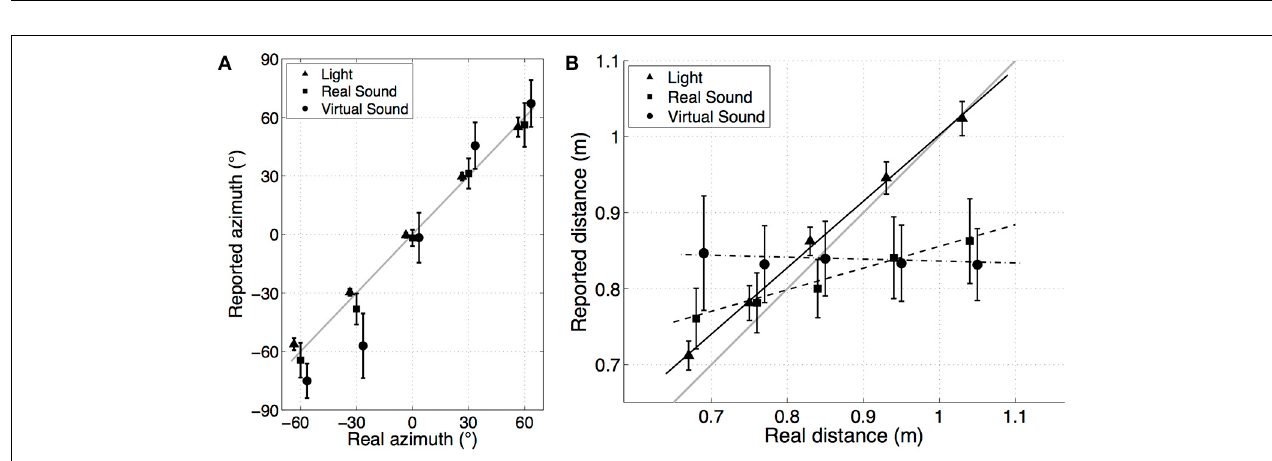
stimuli distance for each rendering condition: visual ( (cid:2) ), real sound ( (cid:3) ), and virtual sound ( • ). Error bars show one standard deviation across the subjects for each condition. Solid gray lines show linear regression curves for each modality. Gray line shows unity.